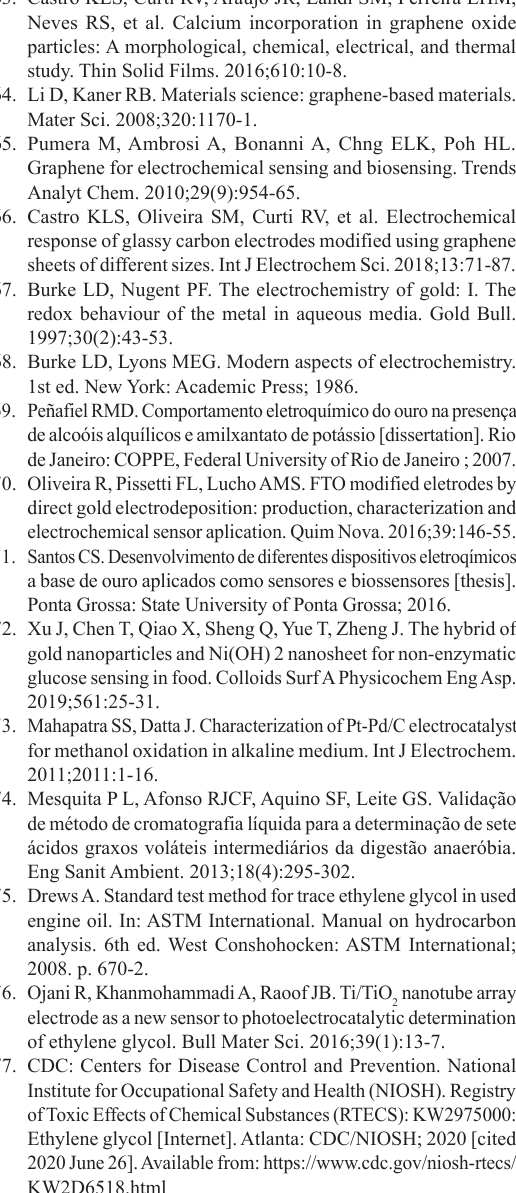
Figure S1 - Surface response plots for the EG determination obtained via CCD. Figure S2 - Voltammetric profile of 20 mmol L -1 ferri- ferrocyanide couple in 3 mol L -1 KCl using GCE, rGO/ GCE, Au/rGO/GCE and Ni(OH) /Au/rGO/GCE electrode 2 at 0.1 V s -1 scan rate. Figure S3 - The (a,b) Bode and (c) Nyquist plots of GCE, rGO/GCE, Au/rGO/GCE and Ni(OH) /Au/rGO/GCE electrodes 2 in 3 mol L -1 KCl containing 20 mmol L -1 [Fe(CN) ] 3− . 6 Figure S4 - The analytical curve for EG standards in 0.50 mol L -1 KOH (EG oxidation peak area versus EG concentration) using Ni(OH) /AuNp/rGO/GCE 2